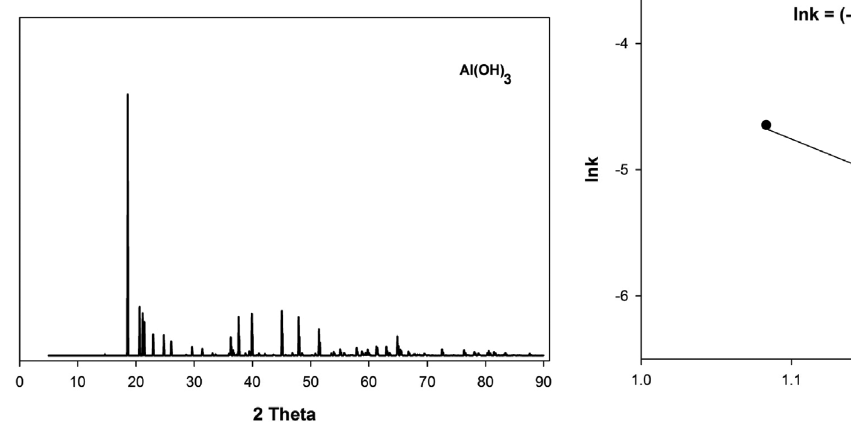
Fig. 8: XRD pattern of Al(OH) 3